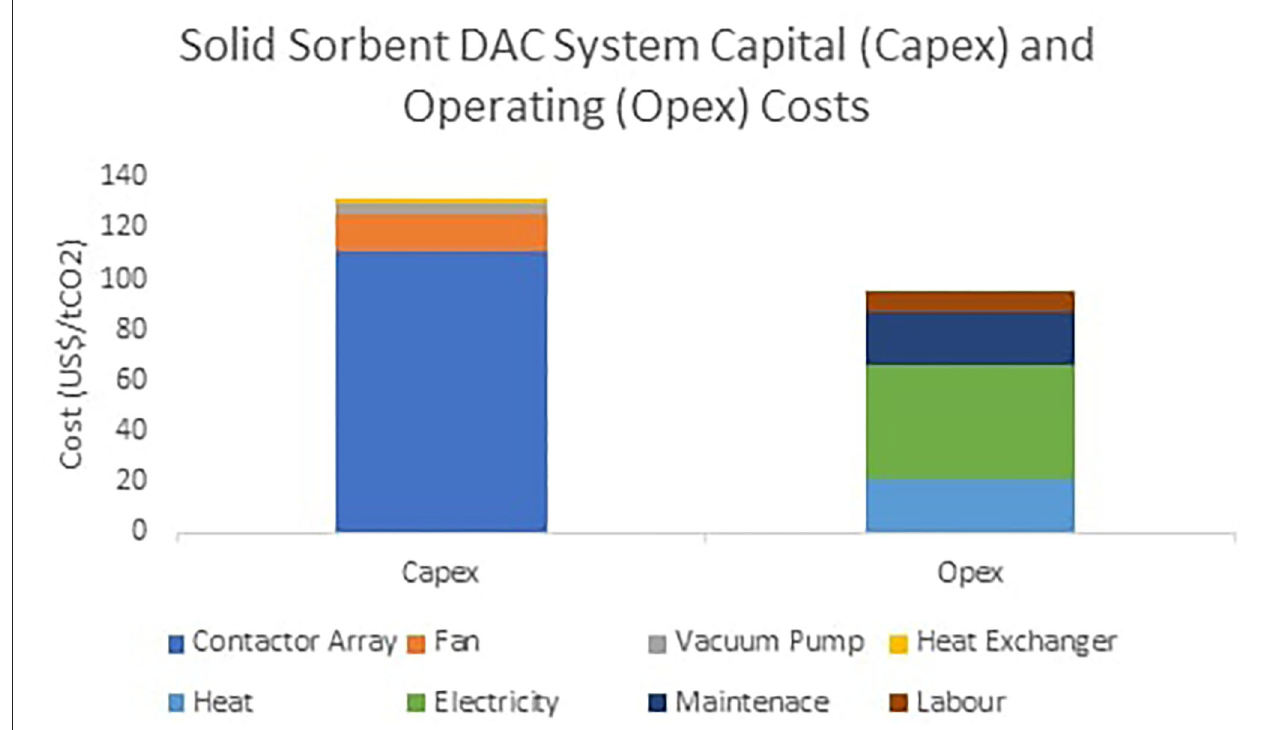
FIGURE 2 | Estimated annualised capital (Capex) and operating (Opex) costs for a solid sorbent direct air capture system with a capacity of 1 Mt/year of CO 2 removal. Graph by Carbon Infinity, based on Wilcox (2019) Graph and National Academies of Sciences, Engineering and Medicine (2019) Data.